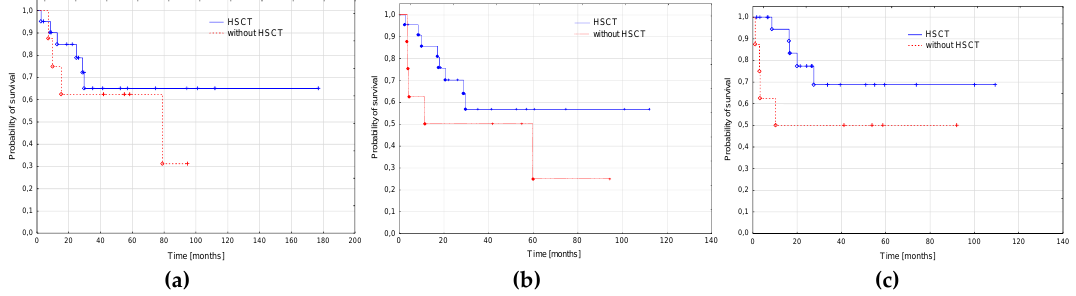
Figure 5. Survival curves depending on the hematopoietic stem cell transplantation (SCT). (a) Probabilities of 3-year overall survival: patients treated with SCT (n=22) - 0.65 ±0.09 , patients treated without SCT (n=13) - 0.62 ±0.11 ; p=0.427 (b) Probabilities of 3-year event free survival: with SCT – 0.57 ±0.09 , without SCT - 0.50 ±0.11 ; p=0.250 (c) Probabilities of 3-year relapse free survival: with SCT – 0.69 ±0.09 , without SCT – 0.50 ±0.11 ; p=0.152.